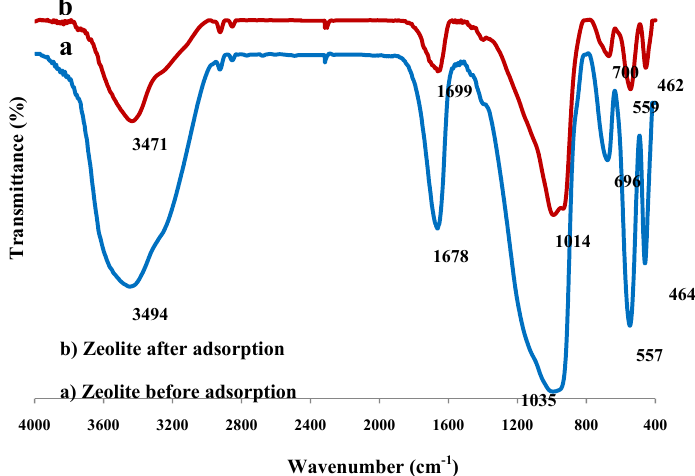
Fig.17 FTIR of nano LTA zeolite before and after ion exchange process Fig. 17. FTIR of nano LTA zeolite before and after ion exchange